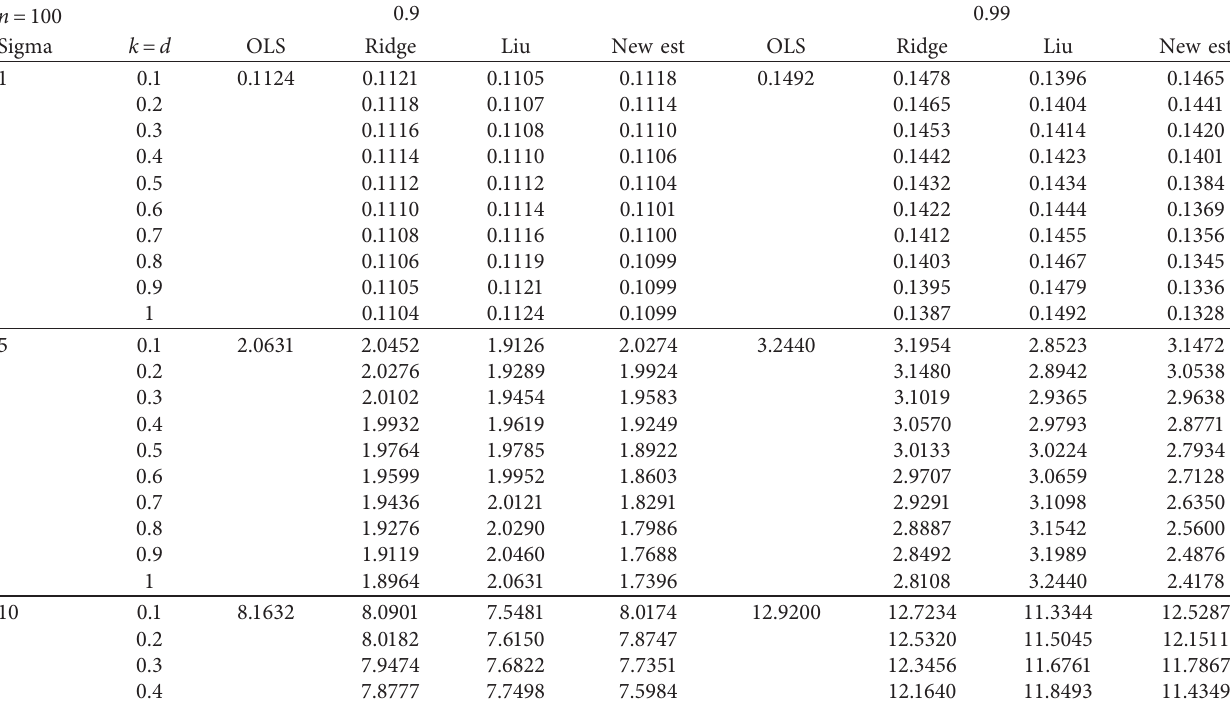
Table 3: Estimated MSE when n � 100, p � 3, and ρ � 0.70 and